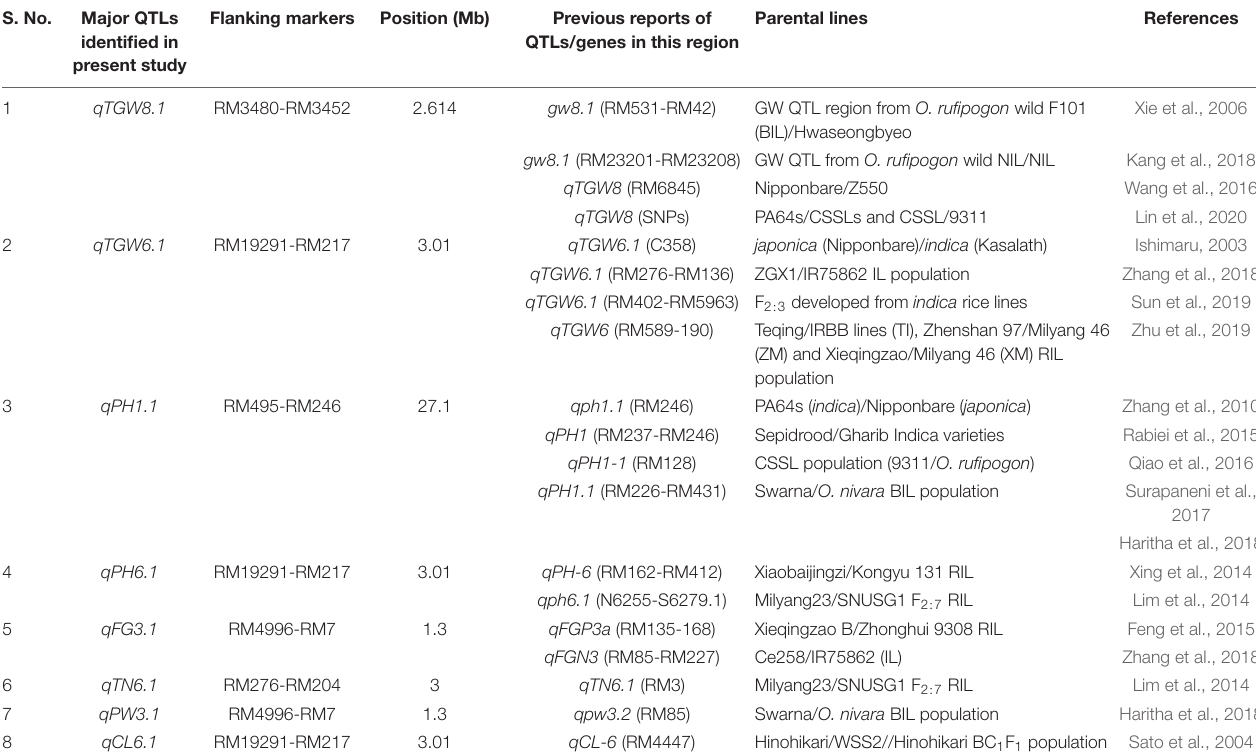
TABLE 4 | Major QTLs identified in present study compared to previously reported